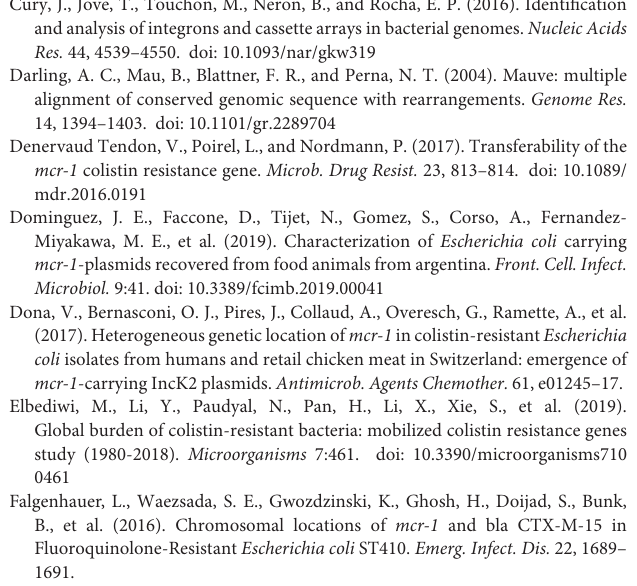
Supplementary Table 4 | Overview of insertion sequences detected in the plasmids of this study. Numbers indicate the count of that IS element in the plasmid sequence. Of these, boldface numbers in red indicate the number flanking the mcr -1 gene (distance ≤ 3 kbp). Supplementary File 1 | Inclusion of isolates and patients January 2010 until September 2018 information. The graphic representation indicates the